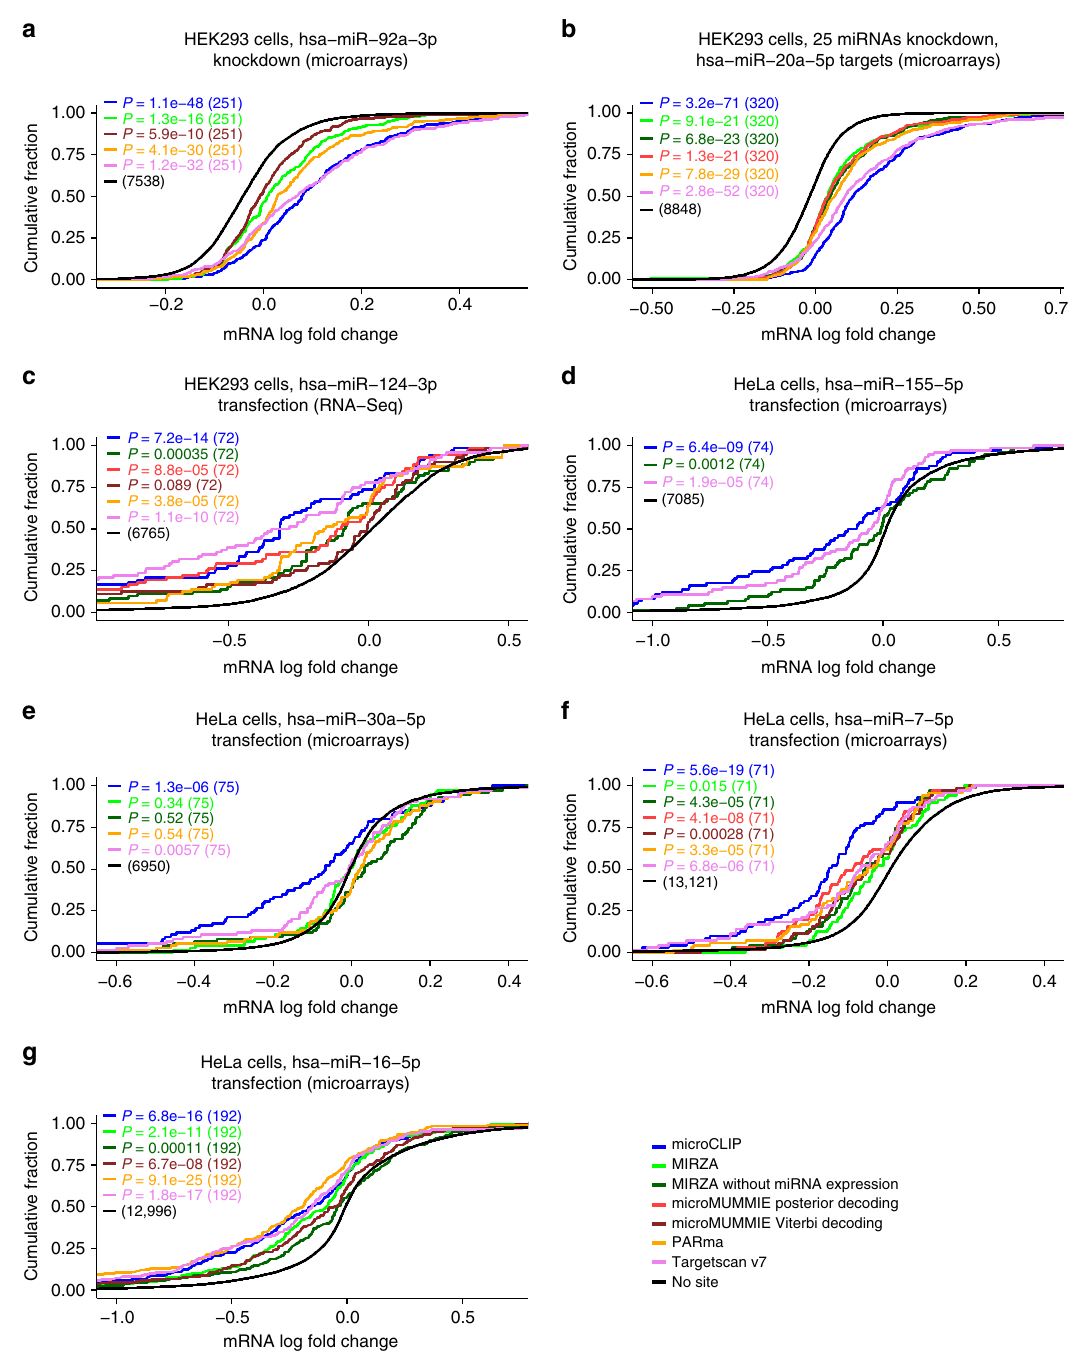
Fig. 7 microCLIP performance compared to MIRZA, microMUMMIE, PARma, and Targetscan v7 was examined in seven public gene expression pro fi ling datasets following miRNA transfection or knockdown in HEK293 and HeLa cell lines. miRNA-target interactions for AGO-CLIP in silico approaches